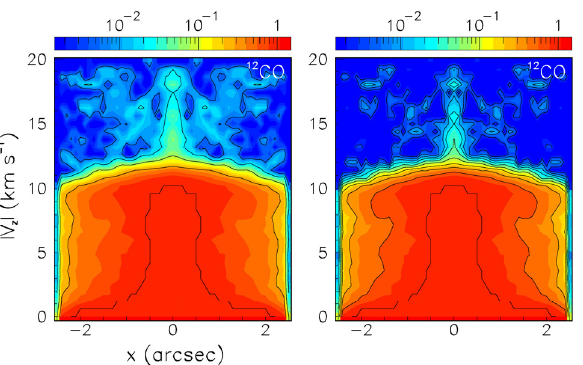
Figure 4 : P–V maps of the intensity (Jy arcsec − 1 ) for centrally symmetrized CO observations for a 1.5 σ noise cut (left) and for a 2 σ cut